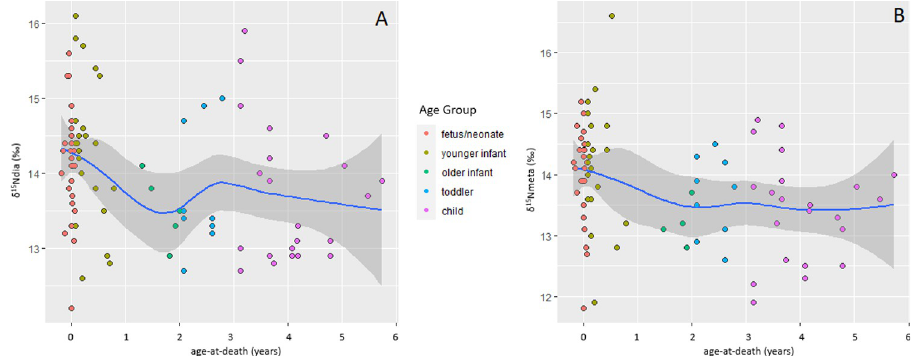
Fig 6. δ 15 N values of � 6-year-olds from Beemster. A) Diaphyseal values, B) metaphyseal values. The blue line is the best-fit smoothed (local) regression line (using loess algorithm) and the grey bands are the 95-percent confidence